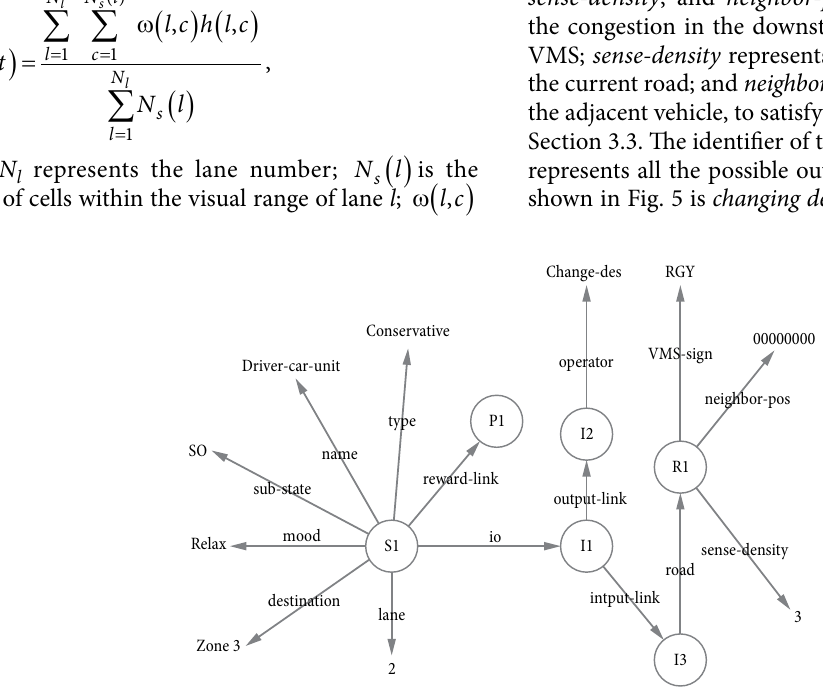
Fig. 5. Hierarchical structure of WM in